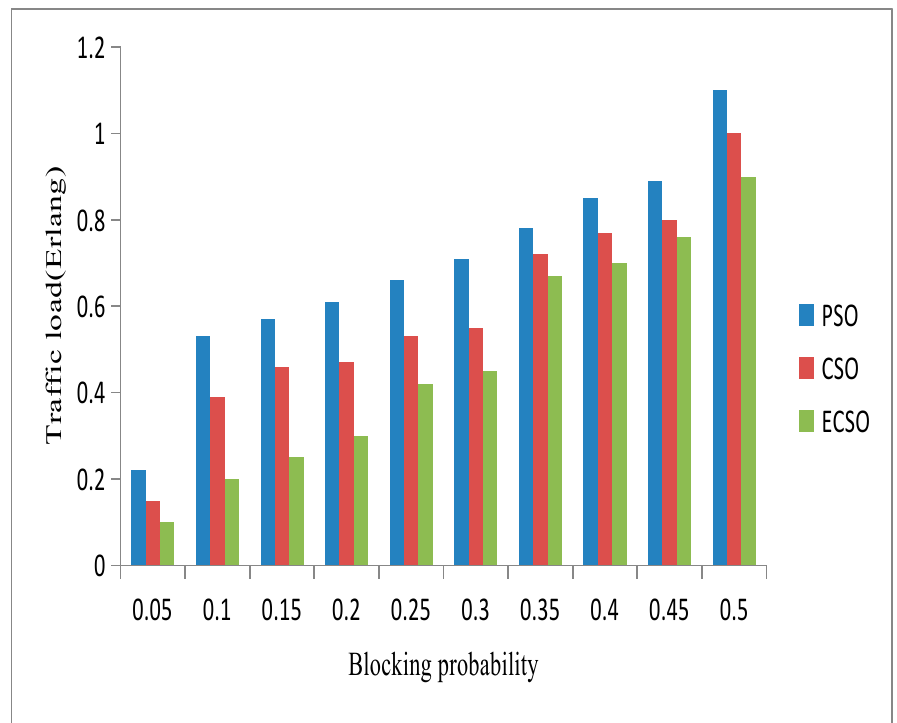
Figure 7. Comparative analysis of blocking probability against existing methods.